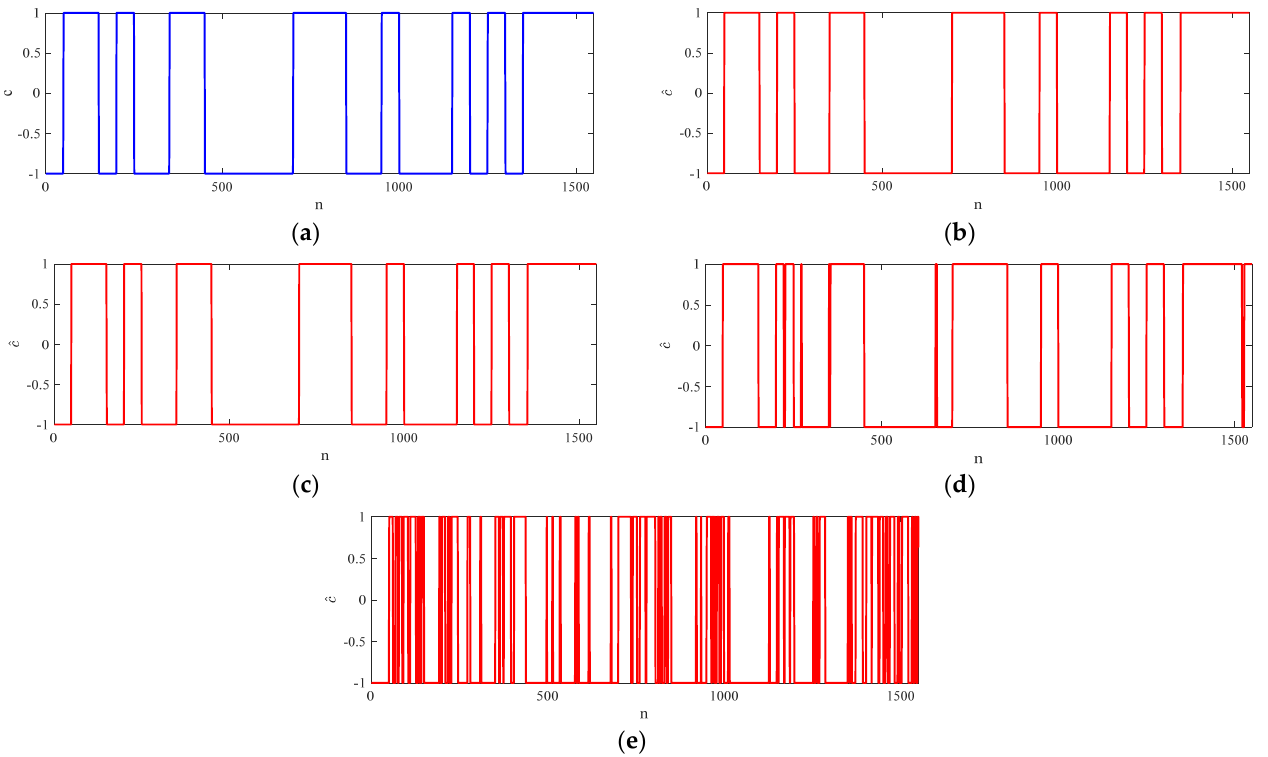
Figure 9. The estimated PN codes under different SNRs. ( a ) Original sequences; ( b ) SNR = 5 dB; ( c ) SNR = 0 dB; ( d ) SNR = − 5 dB; ( e ) SNR = − 10.